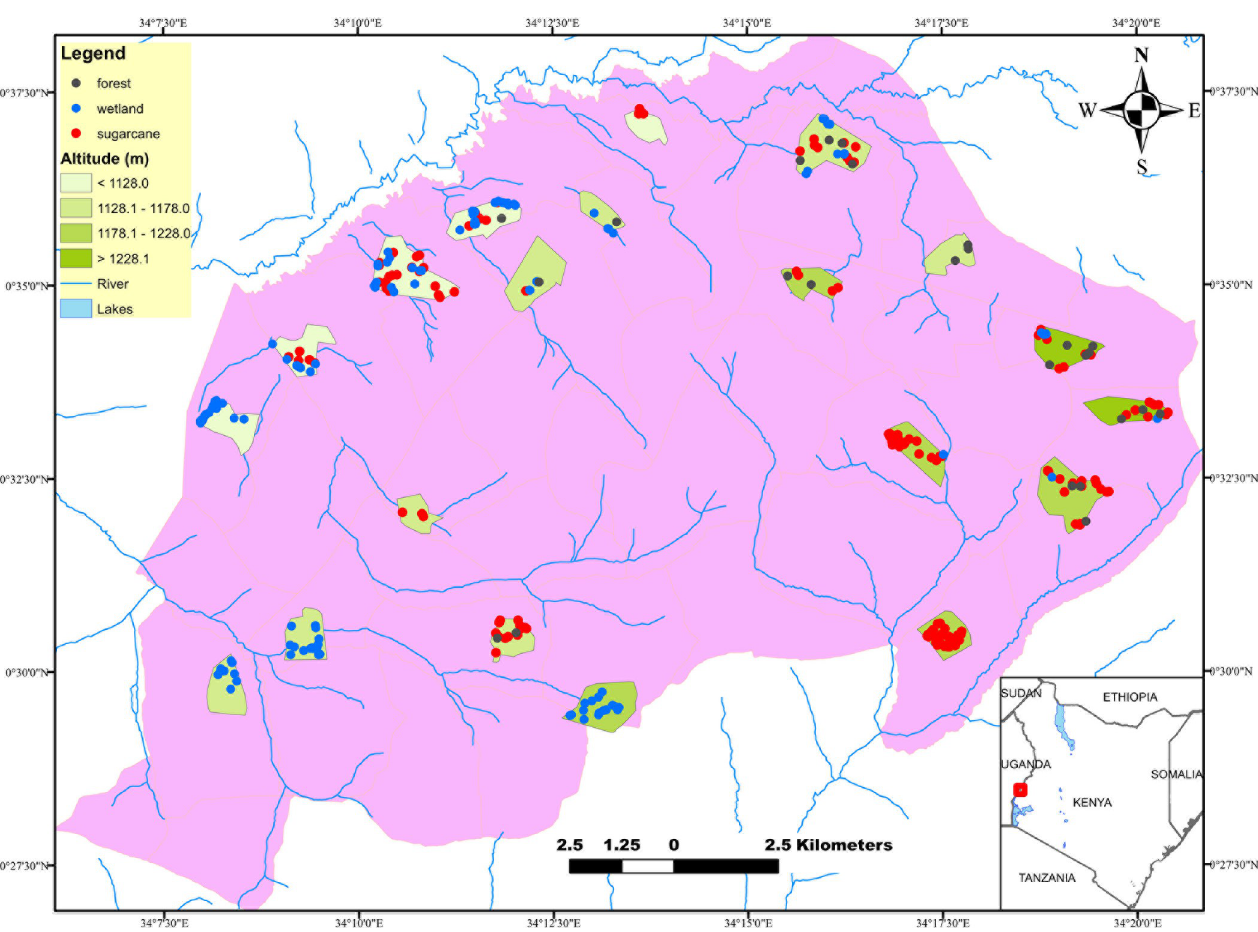
Fig 1. Map showing study site, 20 clusters sampled, altitudinal transects and habitats distribution across the clusters. Source of basemap shapefile